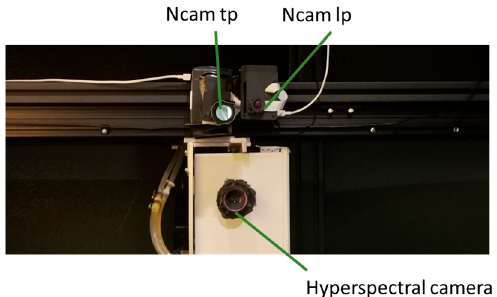
Figure 2. Imaging systems of Ncams and hyperspectral camera.